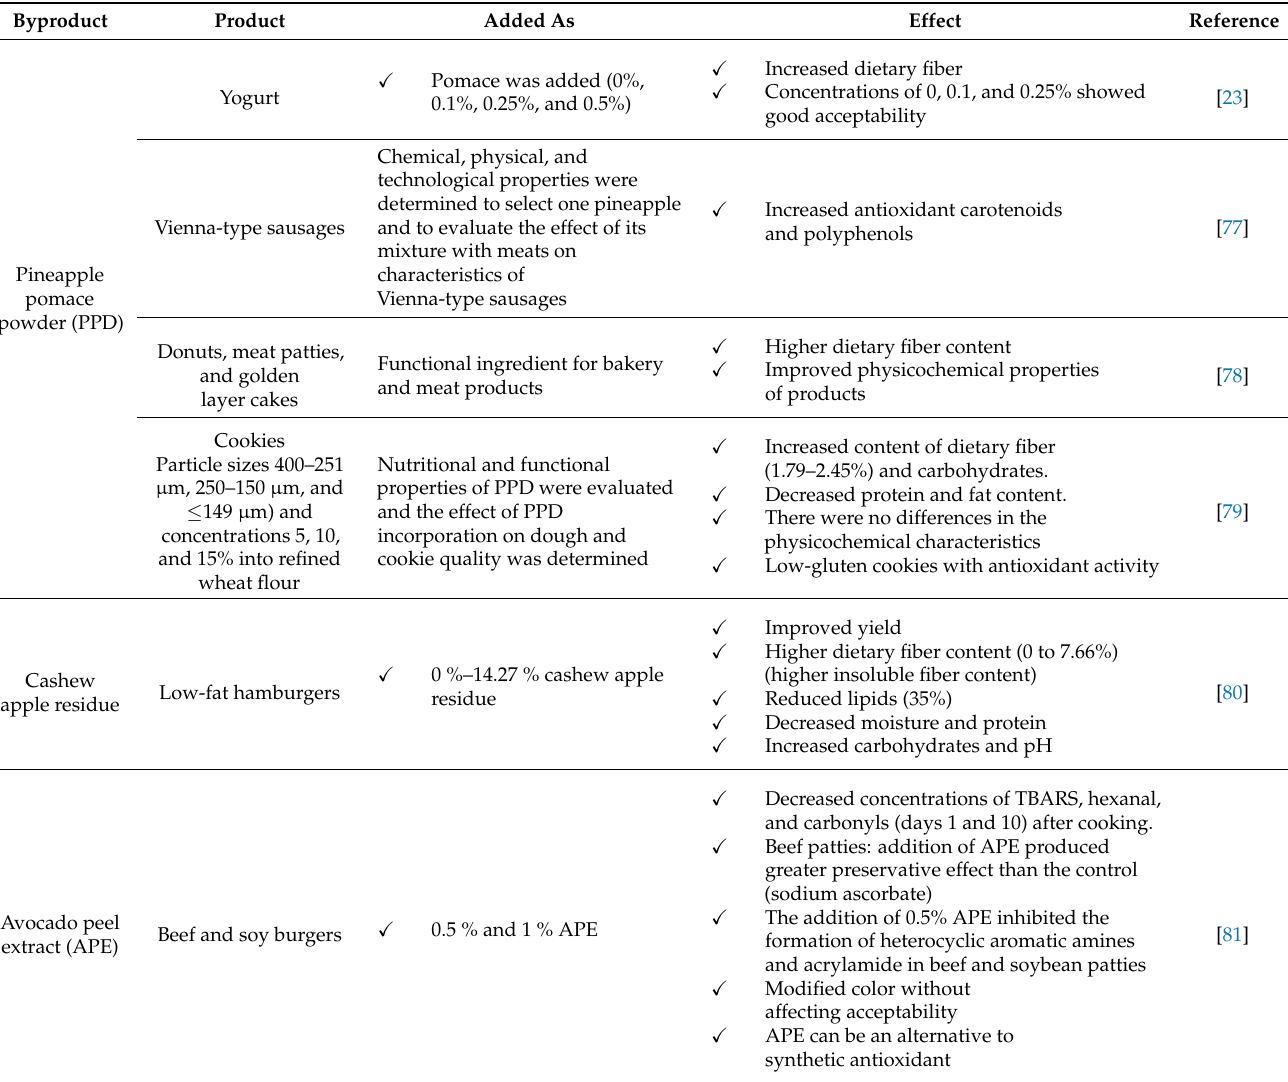
Table 3. Studies of incorporation of agroindustrial byproducts as sources of fiber and